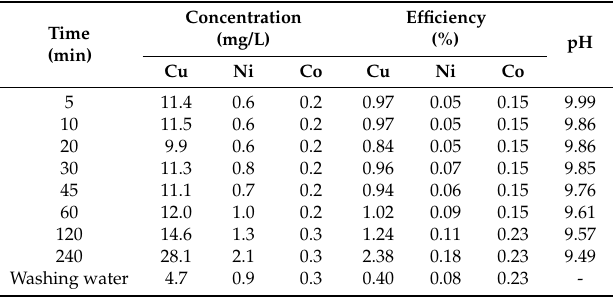
Table 2. Metals concentration and extraction efficiency of ammoniacal leaching at room